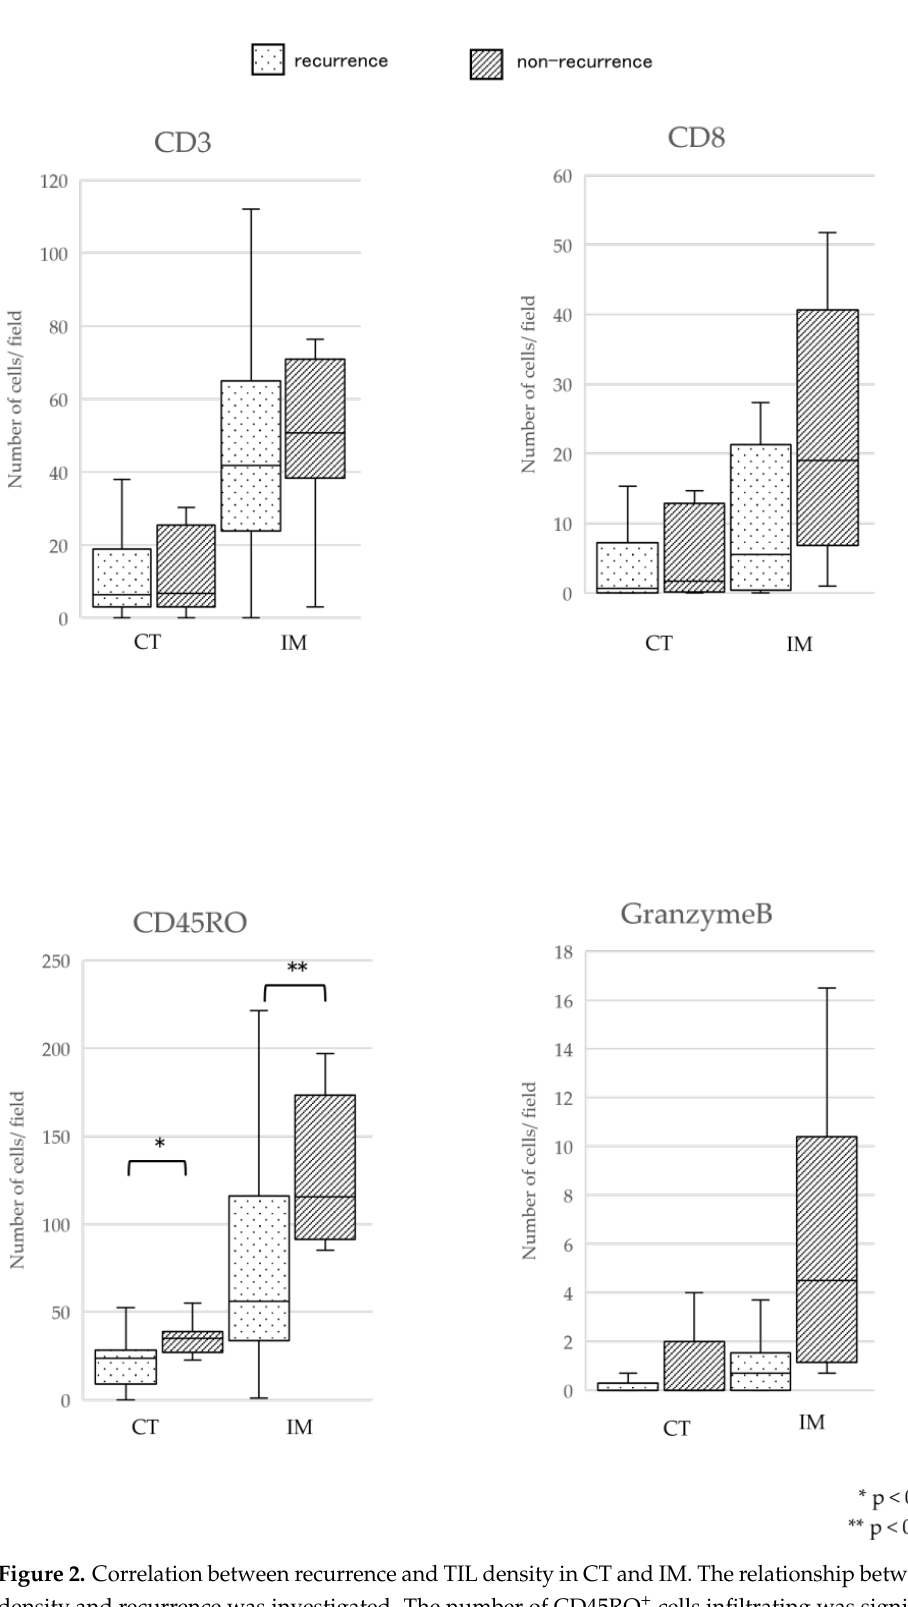
Figure 2. Correlation between recurrence and TIL density in CT and IM. The relationship between TIL density and recurrence was investigated. The number of CD45RO + cells infiltrating was significantly higher in the nonrecurrence group than in the recurrence group in both areas. Differences were determined using the Mann–Whitney U test. * Statistically significant difference at p < 0.05. * p < 0.05. ** p <